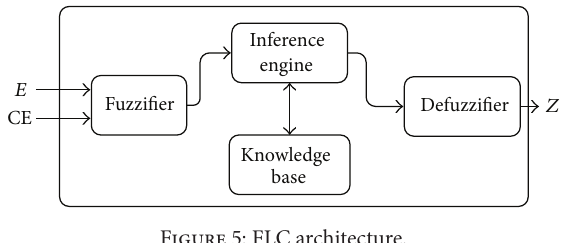
Figure 5: FLC architecture.